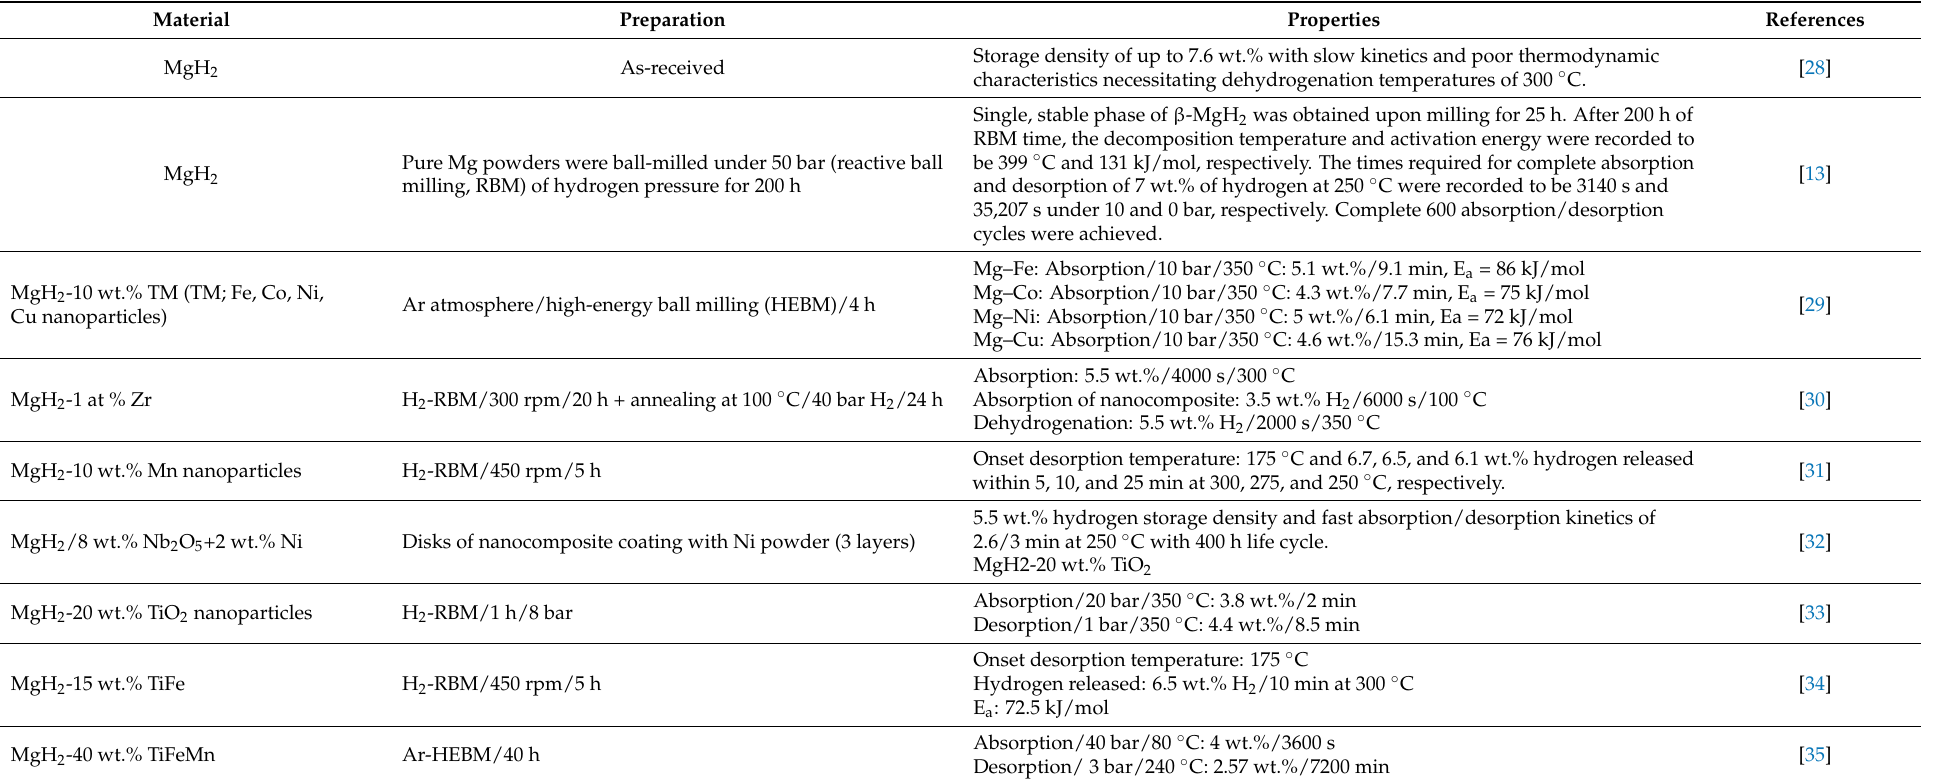
Table 1. Selected MgH 2 -nanocomposite hydrogen storage